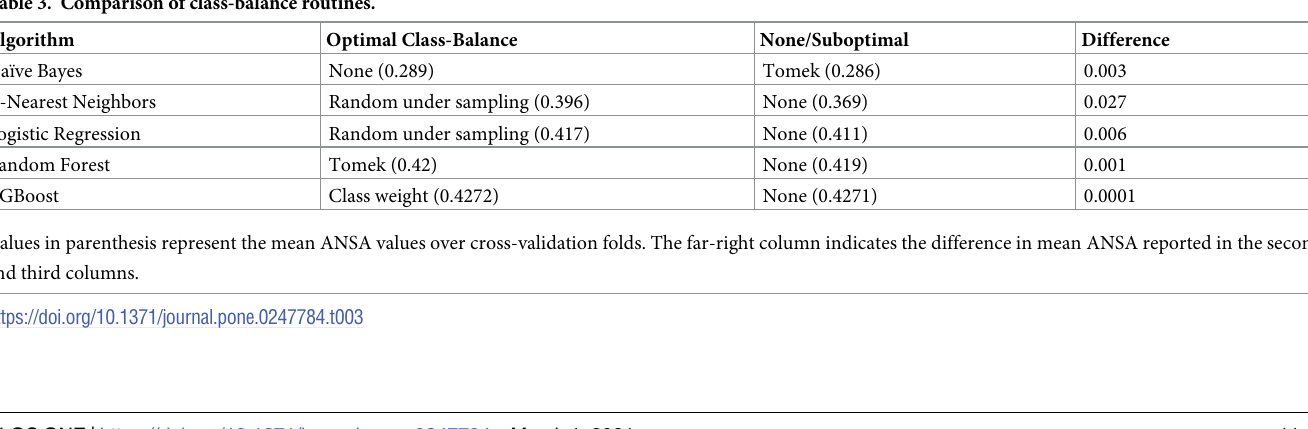
Table 3. Comparison of class-balance routines.